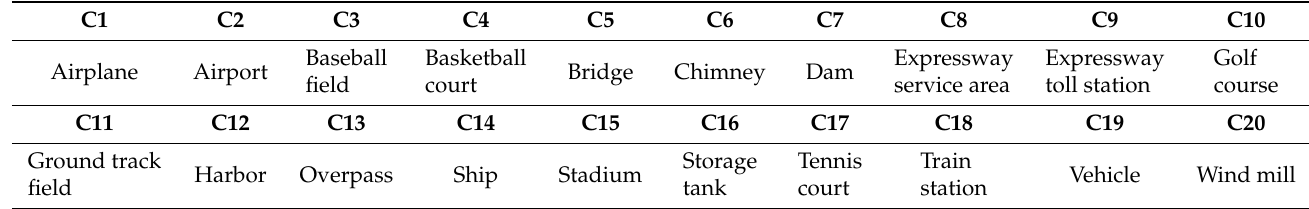
Table 11. The explanation of each category in DIOR.